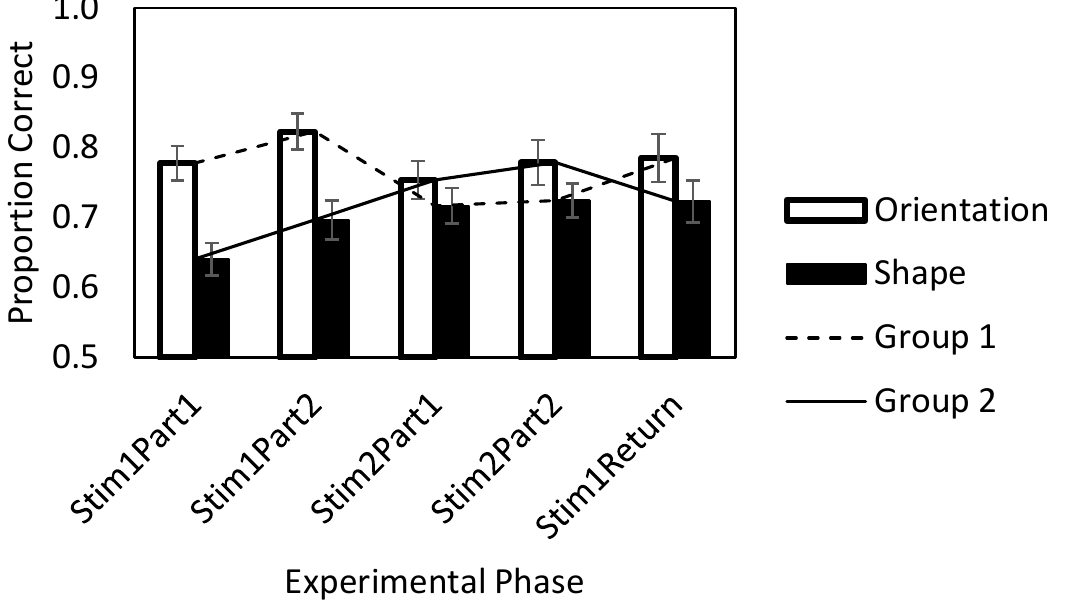
Figure 2. The proportion correct in each phase (x-axis) of each group. Note. Dashed line: Group 1 started with the orientation stimuli. Solid line: Group 2 started with the shape stimuli. Practice phases for the two stimuli were omitted from the figure. The error bars are the standard errors of the